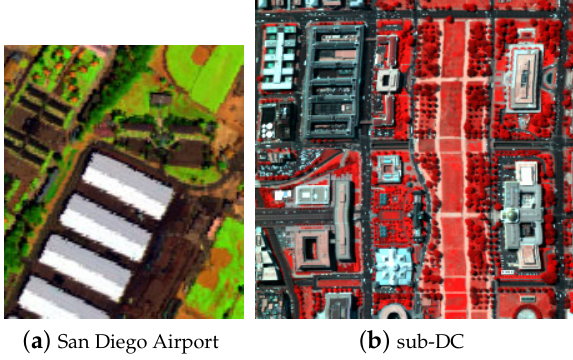
Figure 10. Hyperspectral images (HSIs) used for our experiments: ( a ) sub-image of San Diego Airport data, ( b ) sub-image of Washington Dc